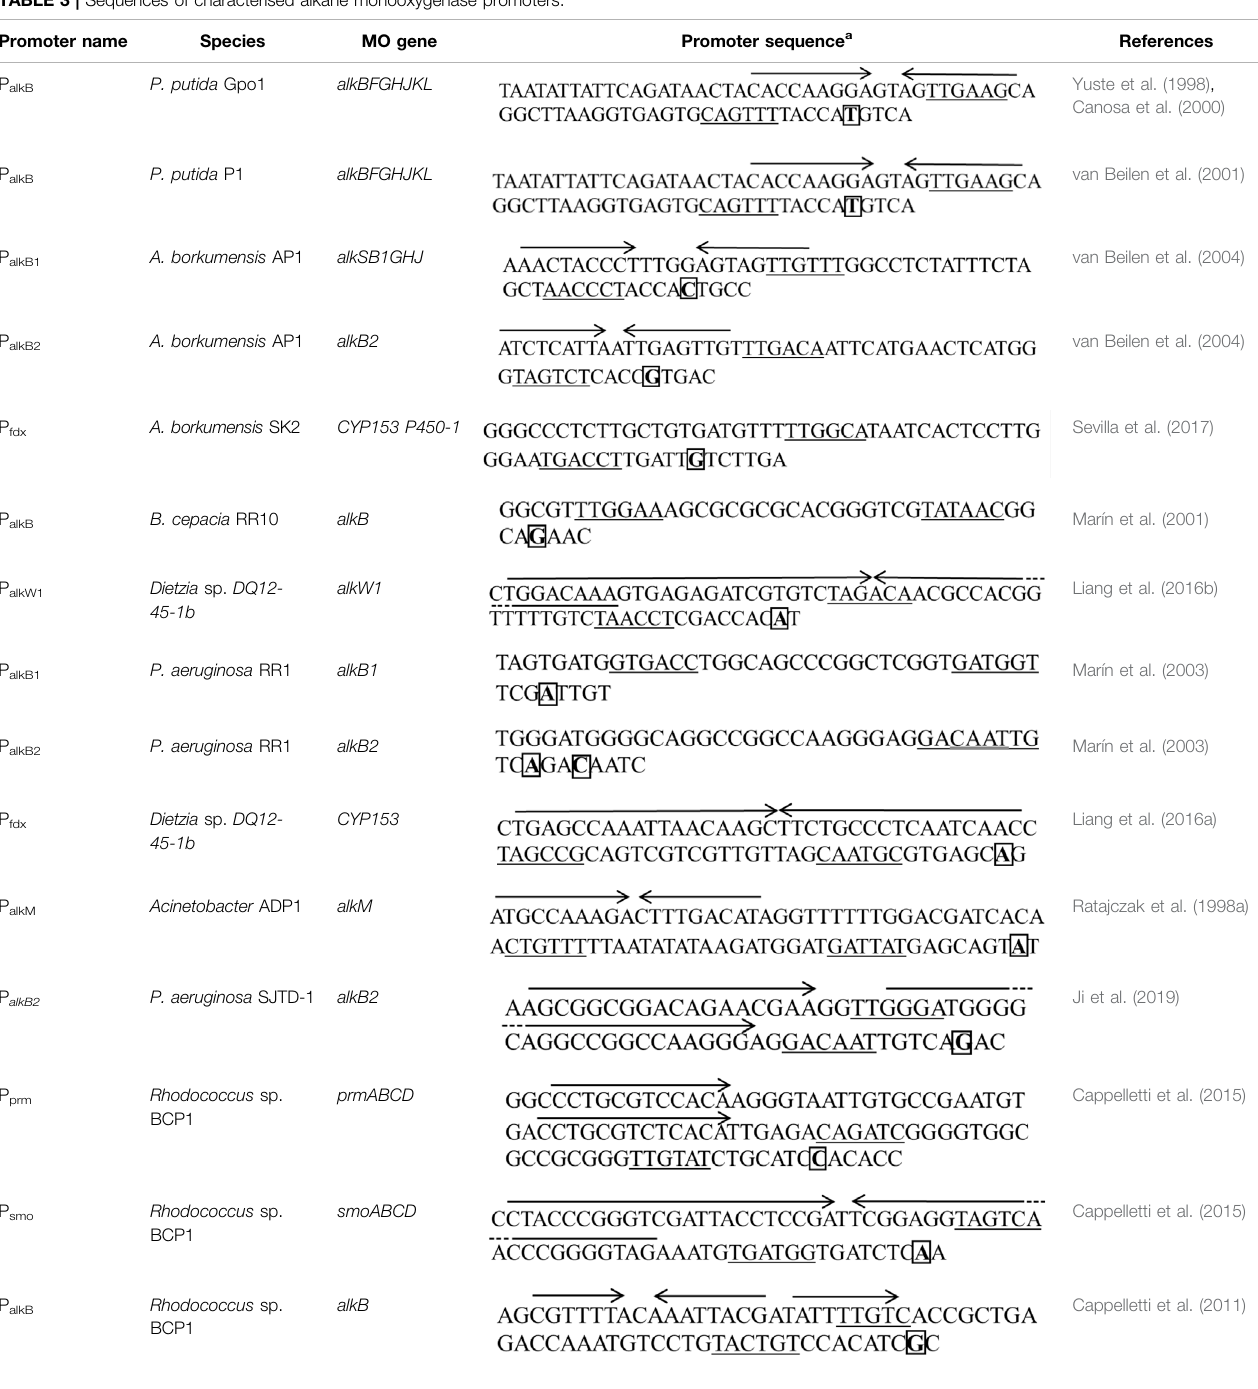
TABLE 3 | Sequences of characterised alkane monooxygenase